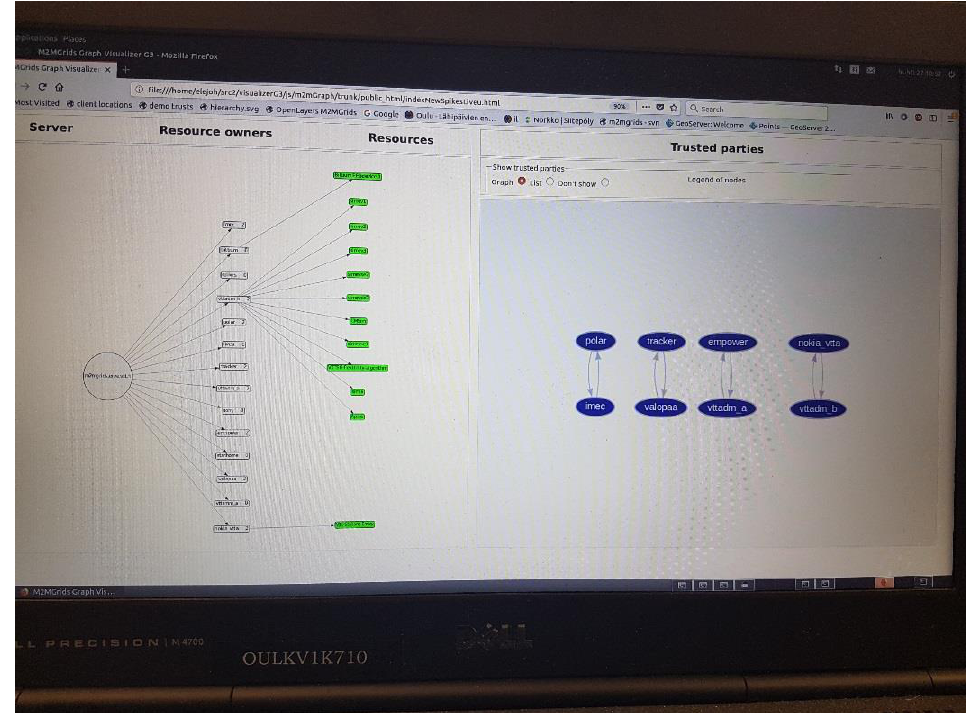
Figure 28. Trust relationship between owners before the alarm event, the tra ffi c accident, has